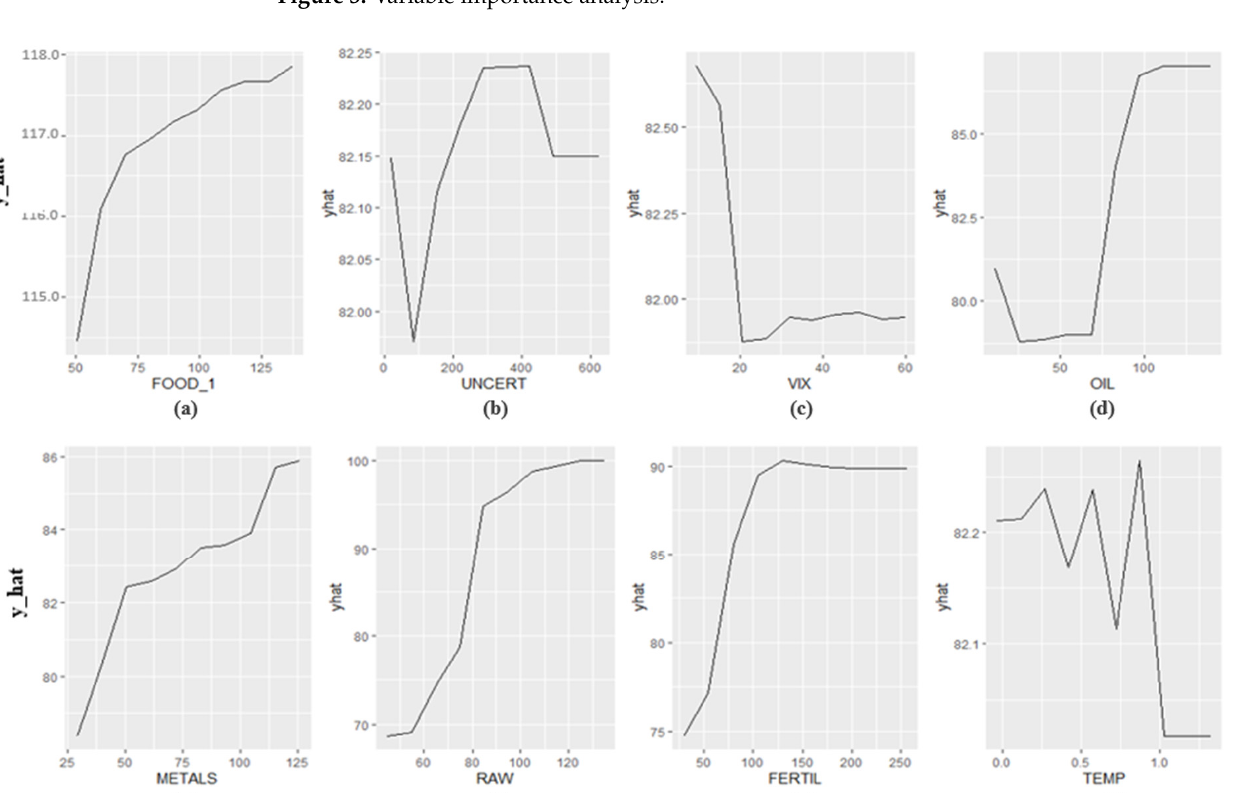
Figure 4. Critical thresholds of the independent variables. (a) FOOD_1, (b) UNCERT, (c) VIX, (d)